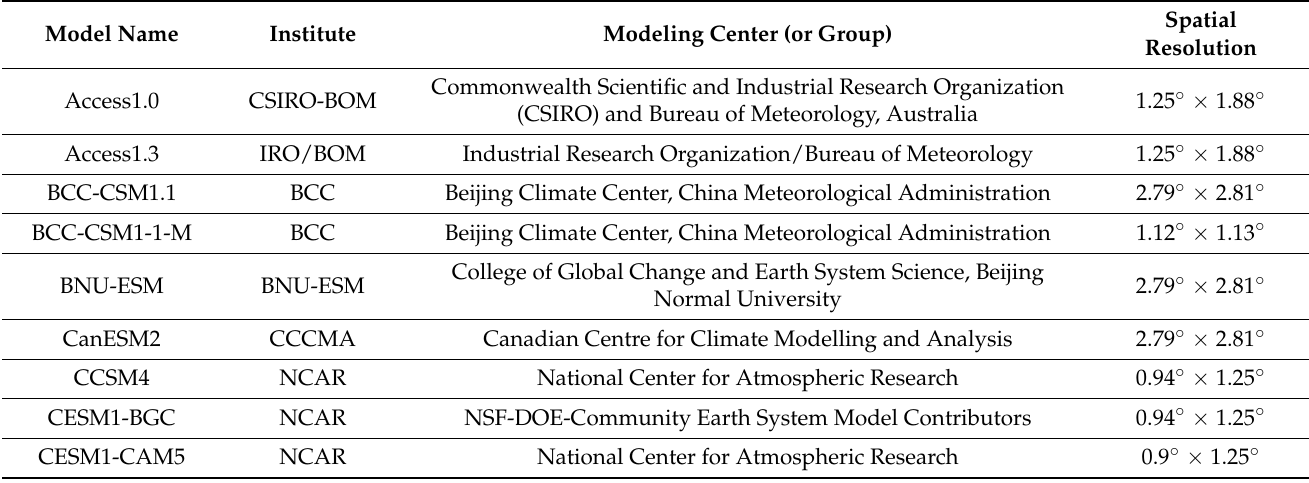
Table 1. List of CMIP5 models utilized for the